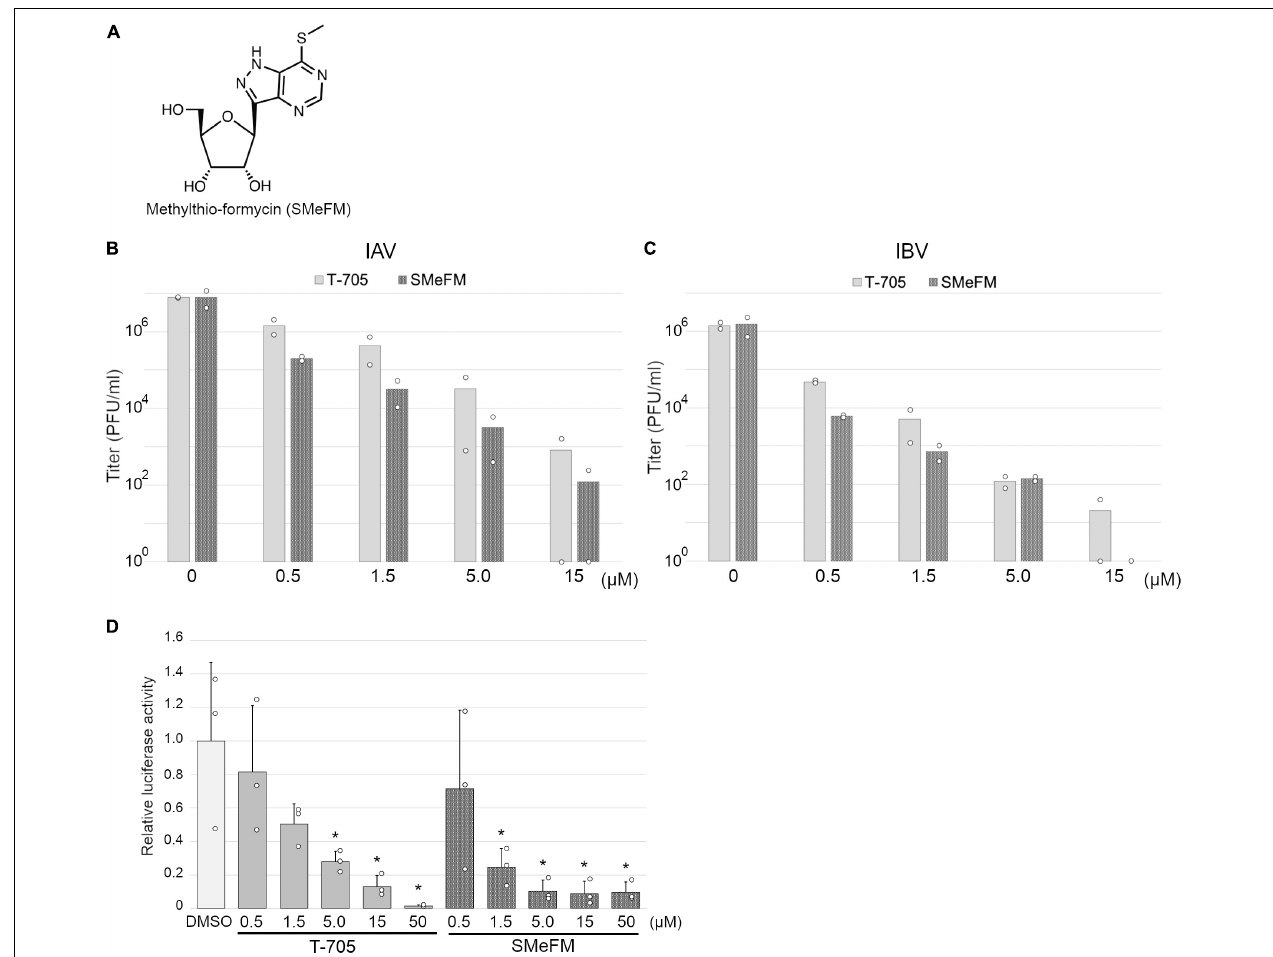
FIGURE 1 | Inhibition of influenza viral polymerase activity by methylthio-formycin (SMeFM). (A) Chemical structure of SMeFM. (B,C) Inhibition of influenza virus propagation by SMeFM. MDCK cells were infected with influenza A [WSN strain; (B) ] or B [Lee strain; (C) ] virus at an MOI of 0.01 PFU/ml and incubated with SMeFM or T-705 for 48 h. The virus titer in the supernatant was determined by plaque assay. The bar indicates the average titer of two independent experiments. The circles indicate the titer of each experiment. The circles of 10 0 are below the detection limit ( < 40 PFU/ml). (D) Viral polymerase activity in the presence of T-705 or SMeFM. Mini-replicon assay was performed by viral polymerase and NP derived from PR8. After 6 h transfection, SMeFM or T-705 was added to the cell culture medium and incubated for 18 h further. The graph indicates average values with standard deviations from three independent experiments. The circles indicate the relative luciferase activity of each experiment. P -values were calculated by Dunnett’s multiple comparison test. An asterisk indicates P -value less than